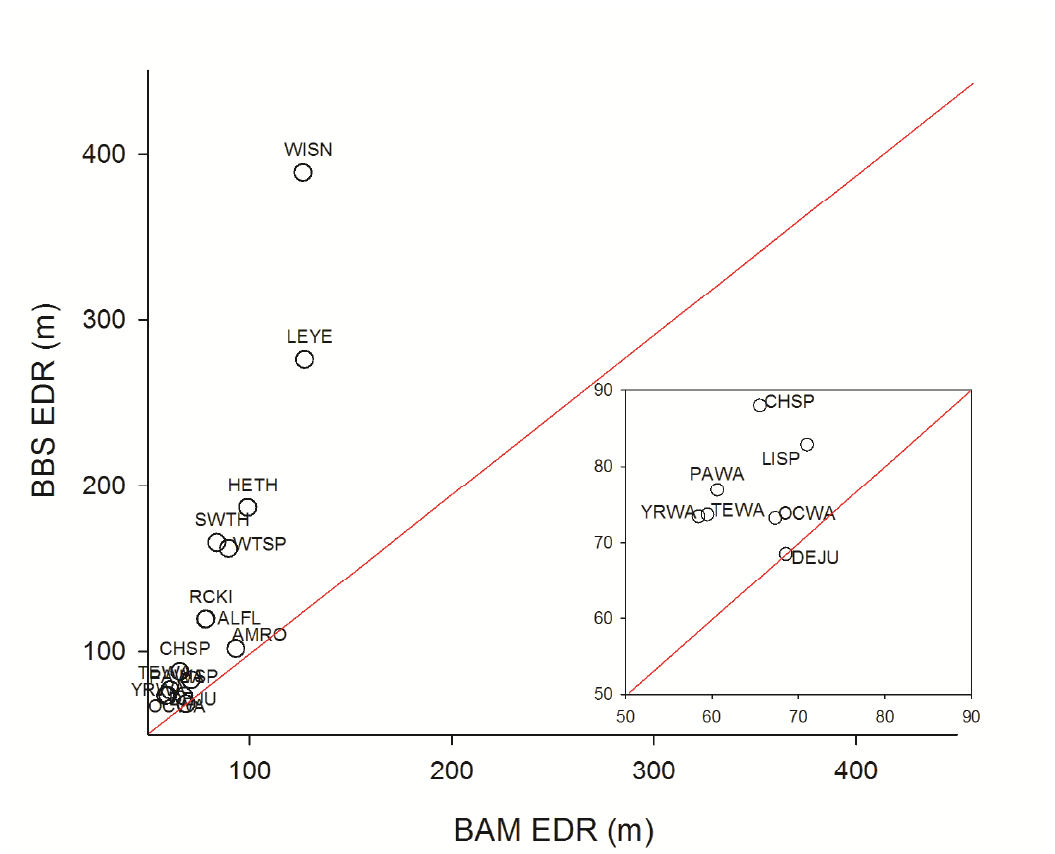
Figure A1.1. Relationship between on-road human BBS and BAM EDR estimates for the 15 forest birds most often detected in this study. Inset graph enlarges clustered area while red line depicts slope of